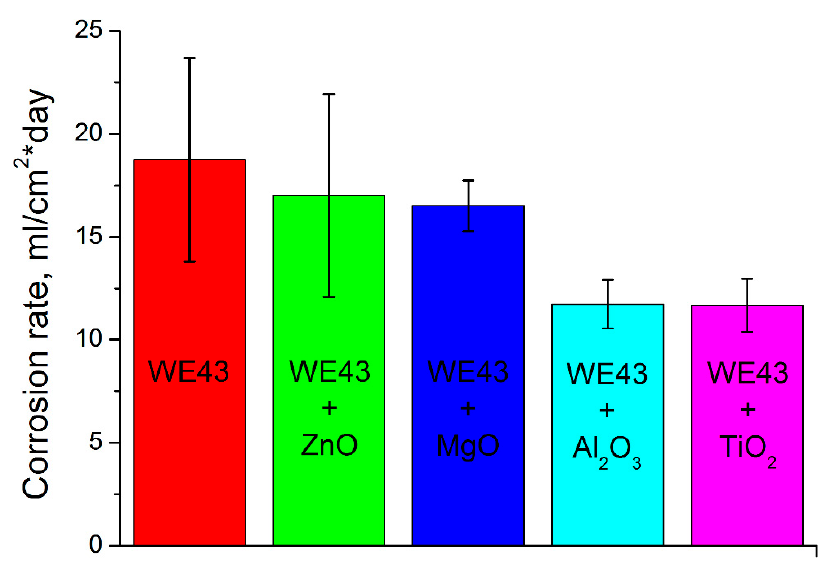
Figure 3. Results of pure and oxide-modified WE43 alloy corrosion tests.